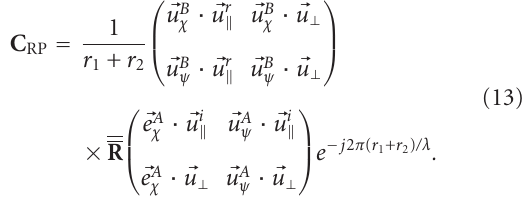
Figure 6: Antenna coordinate system with unit vectors for field components.